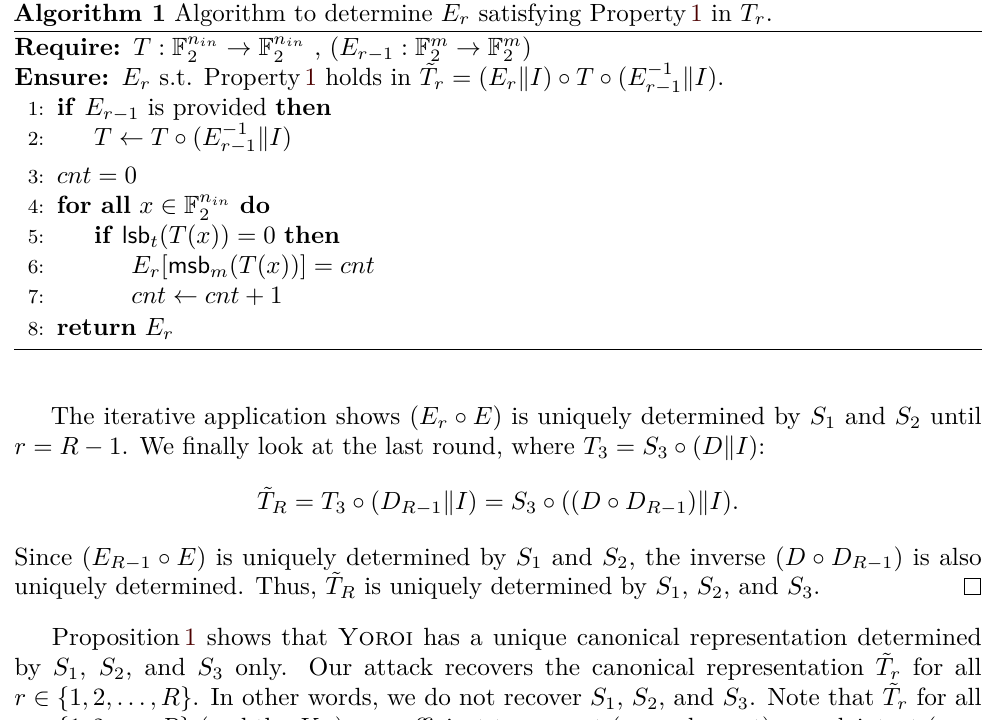
Algorithm 1 Algorithm to determine E r satisfying Property 1 in